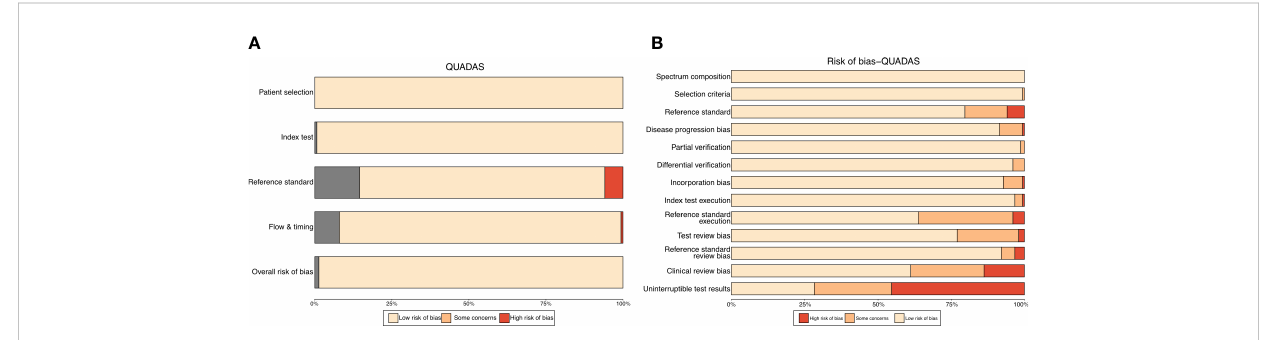
FIGURE 1 Traf fi c light plot (A) for QUADAS-s scores of included studies. Weighted bar plot (B) shows the proportion of information with each risk-of-bias judgement separately for each domain in the